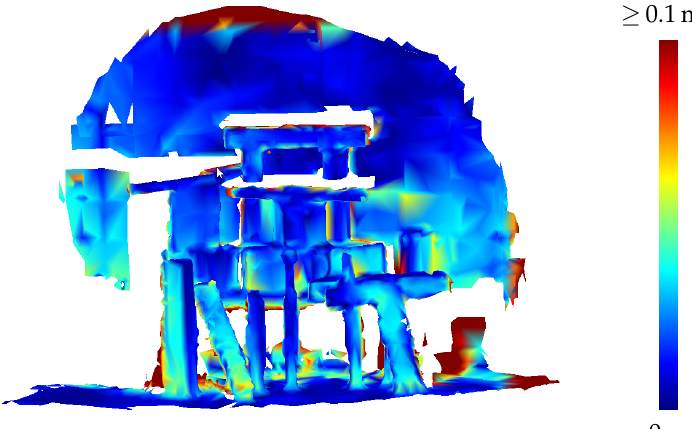
Figure 12. Accuracy of the HoloLens triangle mesh of the three-dimensional scene depicted in Figure 5 evaluated against TLS ground truth